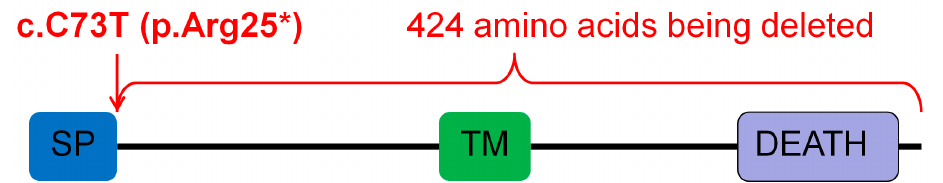
Figure 5. Ectodysplasin A receptor ( EDAR ) mutation c.73C>T (p.Arg25*) introduced a stop codon at amino acid 25 of the encoded protein, truncating 424 amino acids of the protein. SP: signal peptide; TM: transmembrane domain; DEATH: death domain.